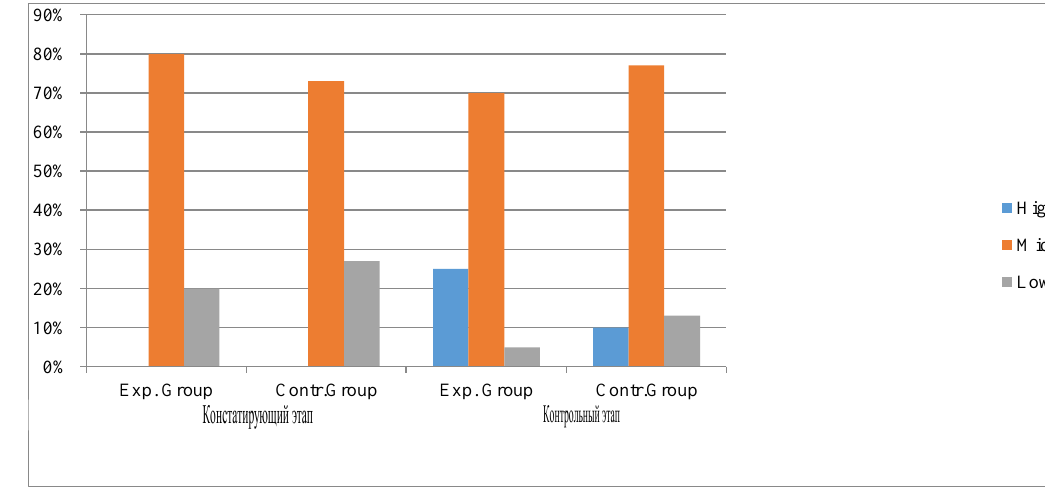
Fig 7. Distribution of students by level of self-evaluation of diagnostic competences formation at ascertaining and control stage of experiment.